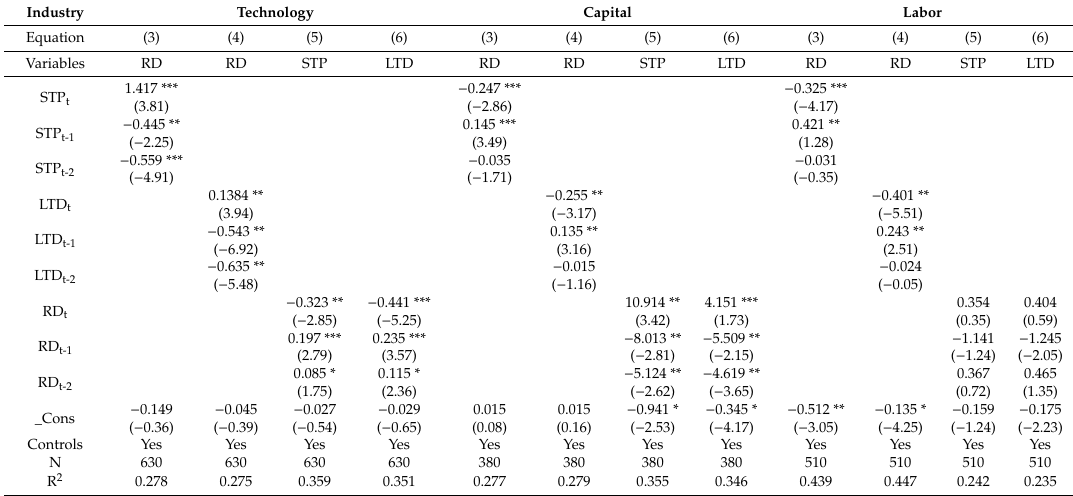
Table 7. The results of 3SLS regression based on